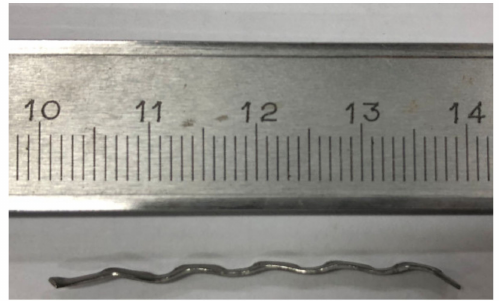
Figure 2. Photograph of steel